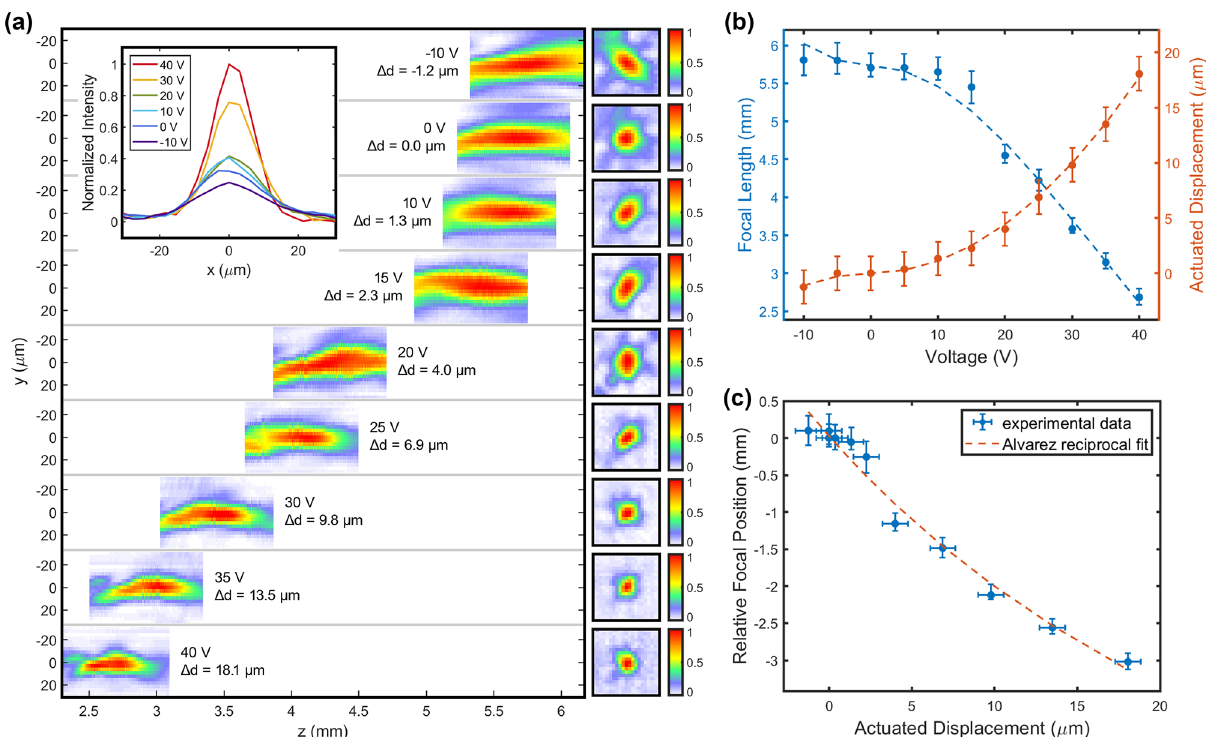
Figure 4. Focal tuning measurements of the MEMS Alvarez meta-optical lens. ( a ) Normalized focal profiles along the optical axis (z-axis) capturing the intensities at 5 µm increments across a 0.8 mm span around the main intensity lobes. Square plots on the right show the intensity distributions in the found focal planes. Inset: normalized intensities across the focal spots at various actuation voltages. ( b ) Actuated displacement and the corresponding focal length modulated by actuation voltage. Dashed lines show the fitting to the theoretical behaviors. ( c ) Tunable focal length as a function of actuated displacement closely follows the theoretical reciprocal Alvarez tuning